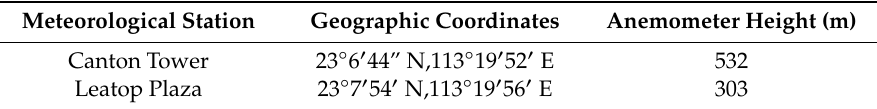
Table 2. Information of meteorological stations.